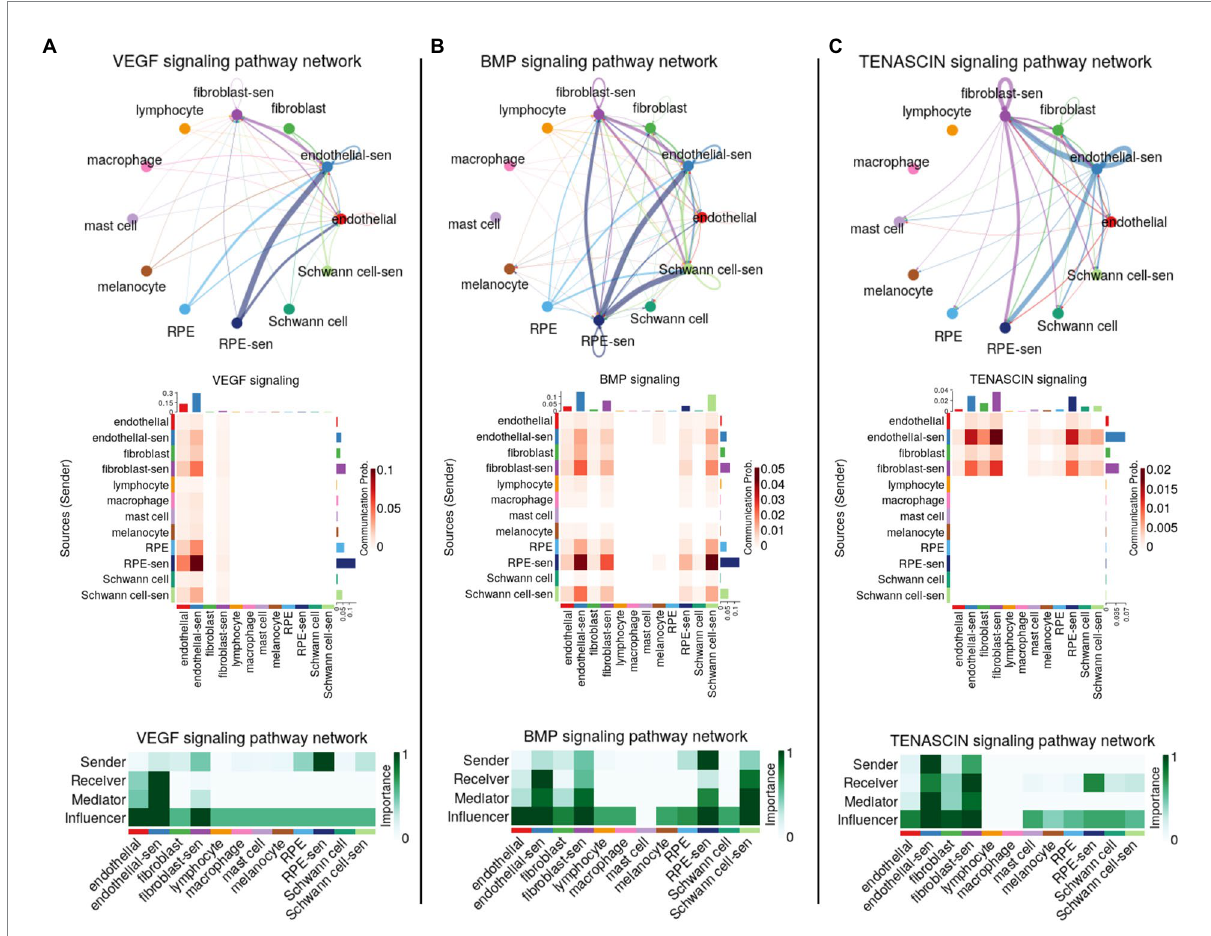
FIGURE 6 Network representation of the impact of senescence on VEGF, BMP and TENASCIN intercellular communication in the RPE/choroid. Signaling network summary between senescent-like and non-senescent cell types for (A) VEGF, (B) BMP and (C) TENASCIN pathways. Cell type to cell type networks (top panels) and heatmaps (middle panels) show the CellChat communication probability (aggregated over all LRIs from the given pathway) between each cell type pair. Centrality heatmaps (bottom panels) show the various CellChat centrality scores across each cell type for the selected